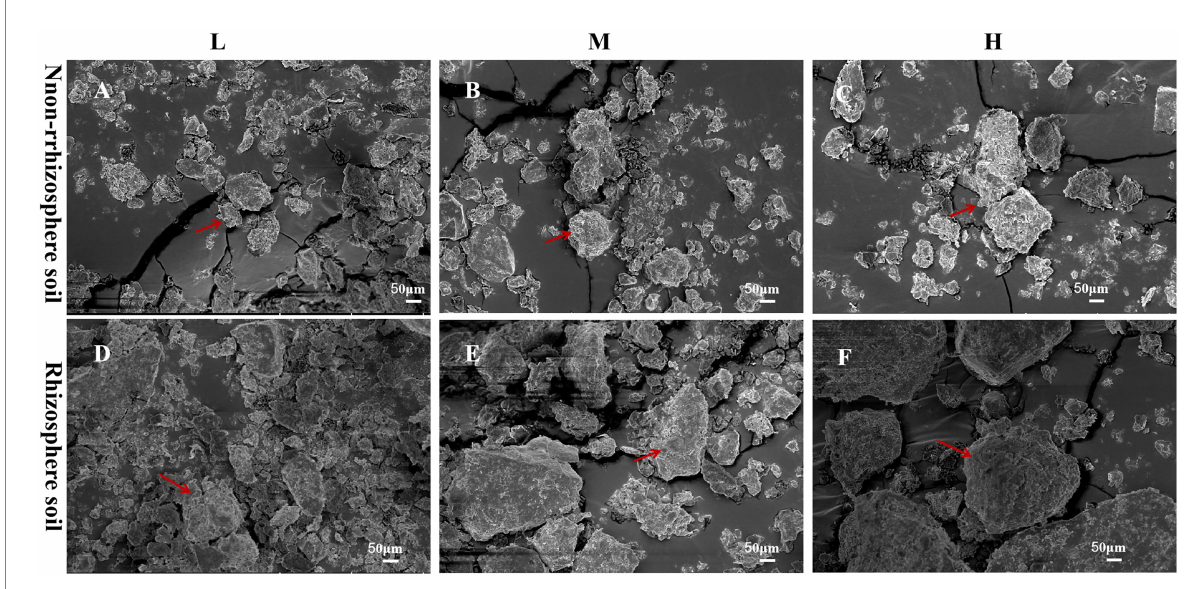
FIGURE 1 Scanning electron microscopy (SEM) images of the soil structure in each plot; (A–C) the rhizosphere soils in L, M, and H, respectively; (D–F) the non-rhizosphere